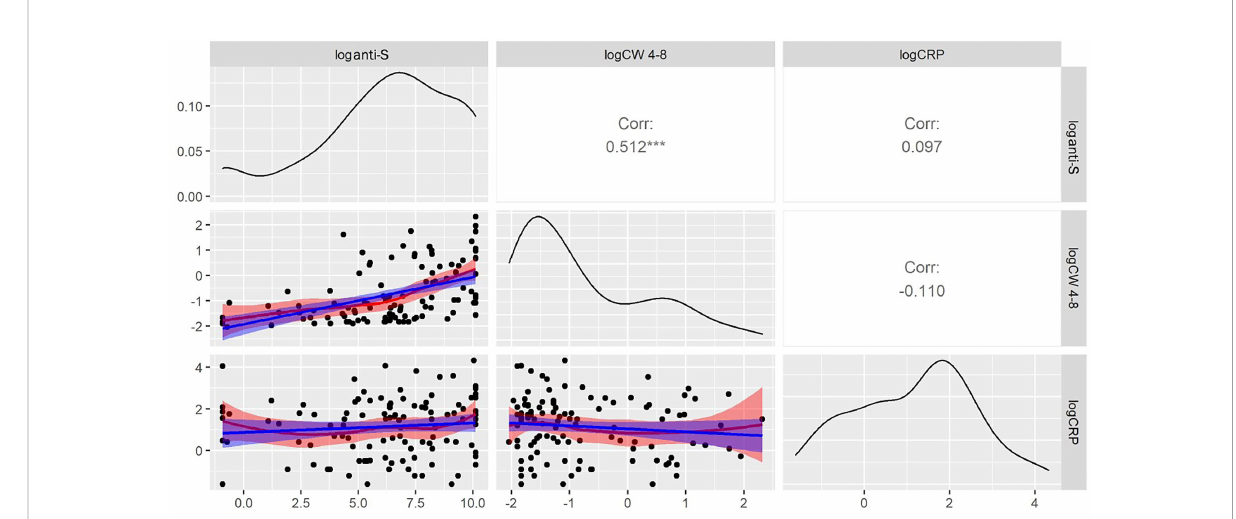
FIGURE 5 Relationships between CRP and anti-S antibody and whole COVID virus-speci fi c CD4+ and CD8+ T-cell response (CW 4-8) levels. In the lower triangle the variables are plotted against each-other, in the diagonals the smoothed distribution of the variables is shown while the squared correlation coef fi cients between the variables are shown in the upper right diagram. Log CRP concentrations are correlated neither with CW 4- 8 nor with anti-S antibody levels. Because of the lack of correlation, the immune response to vaccines (or infection) seems to be unrelated to the in fl ammatory condition of RA patients. *** p<0.001.